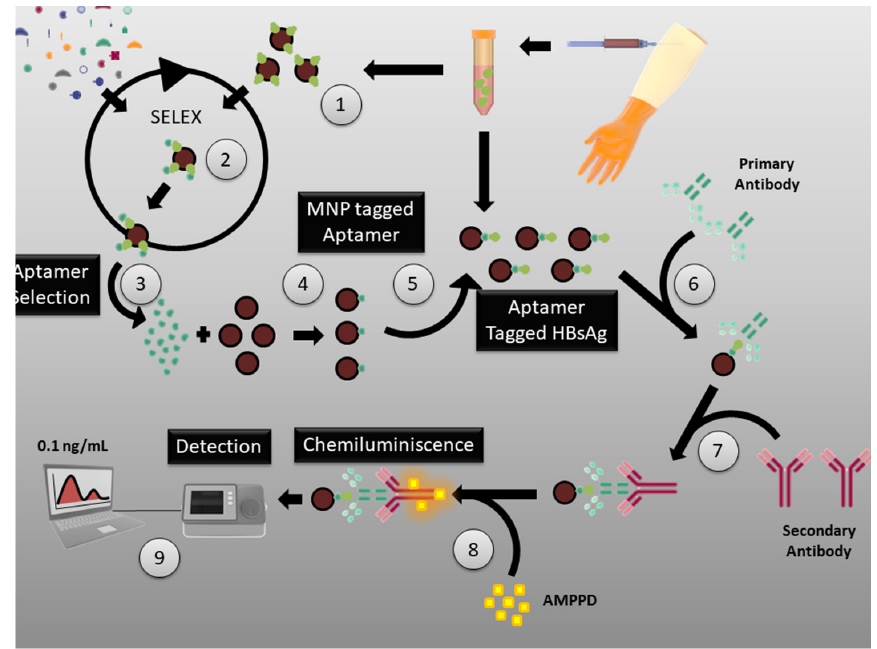
Figure 6. SELEX process for the generation of aptamers against HCV : E1 and E2 proteins of HCV used as targets in SELEX to generate aptamers against virus particles that bind to host cells. CC BY 4.0